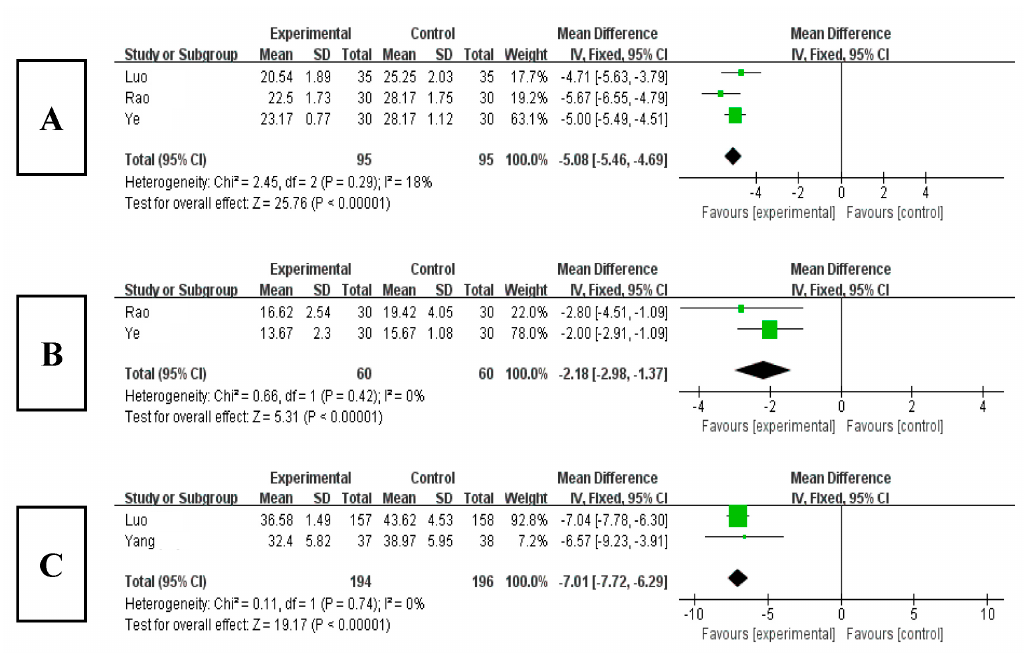
Figure 10. ( A ) Forest plot of HAMD effect size. ( B ) Forest plot of HAMA effect size. ( C ) Forest plot of SAS effect size. SAS effect size [20,21,25,27,29].